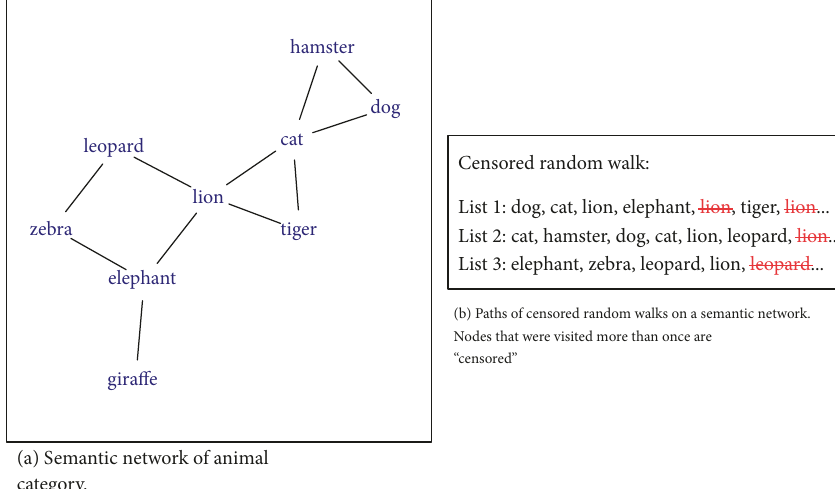
Figure 4: An example of a random walk process on a semantic network to account for responses in a fluency task. Adapted from Zemla & Austerweil